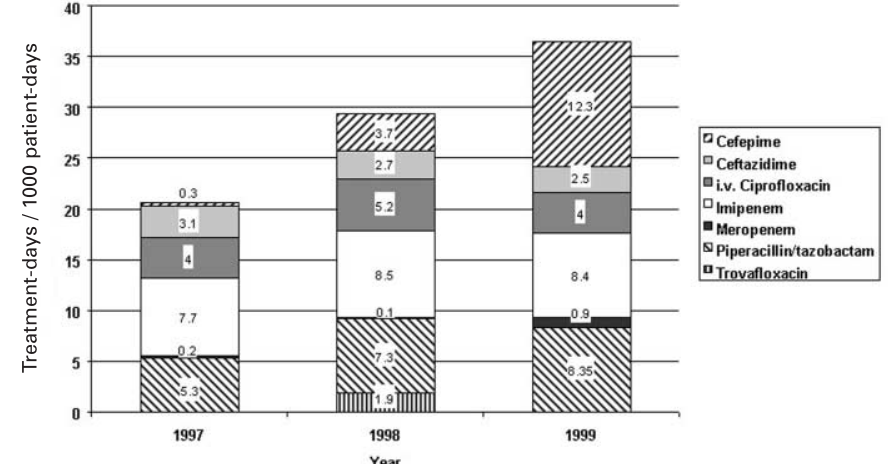
Overall utilisation rates of broad- spectrum antibiotics in the acute